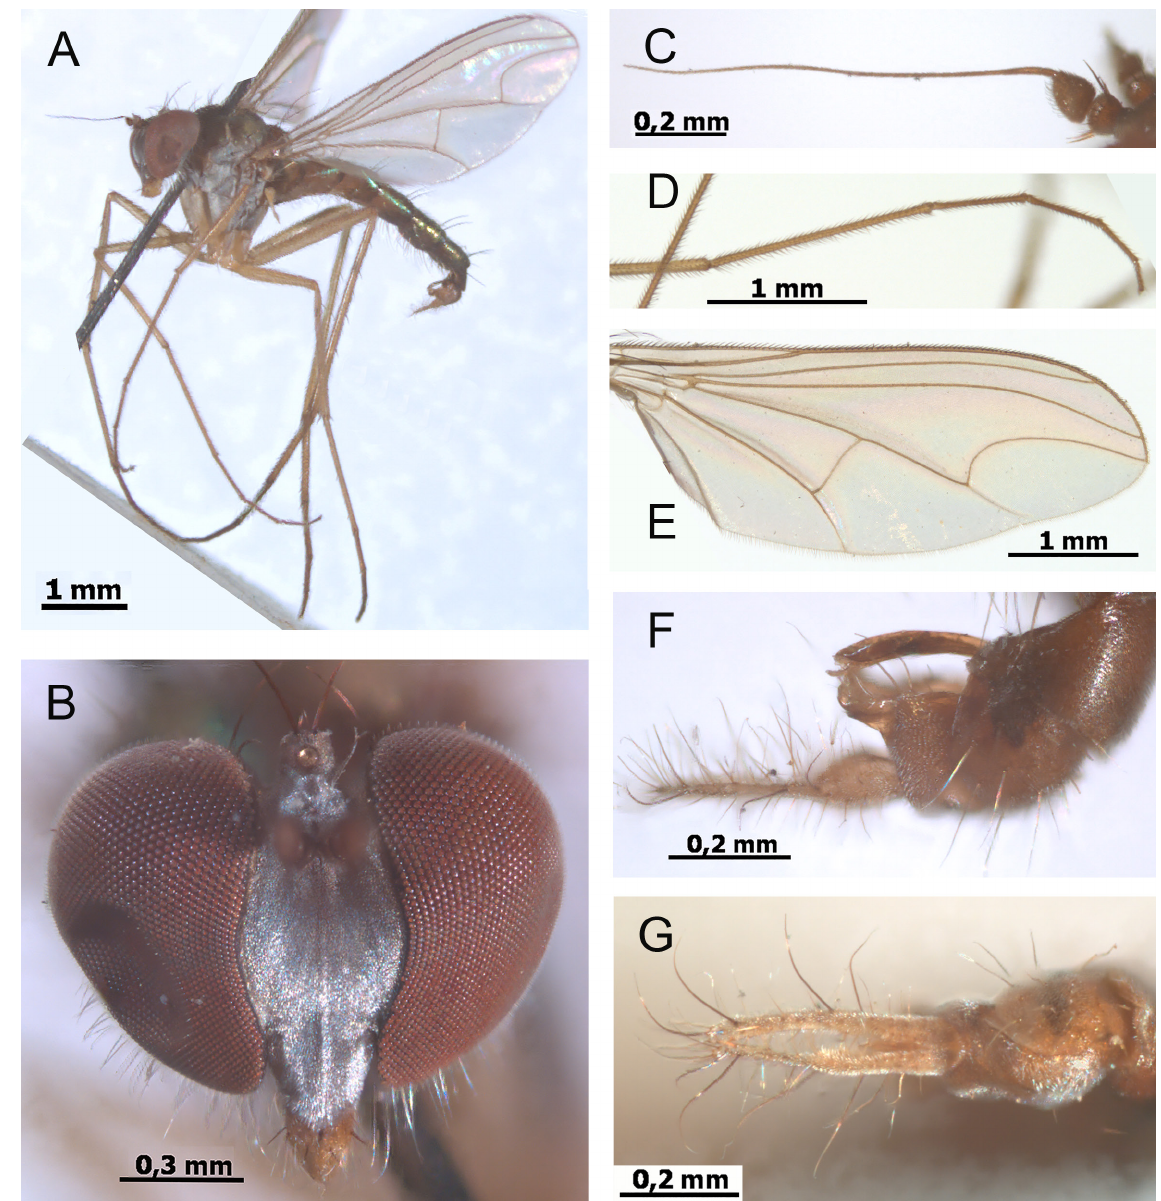
Fig. 3. Amblypsilopus bevisi (Curran, 1927), ♂, Natal, Edendale (NMSA). A . Habitus. B . Head. C . Antenna. D . Fore tarsus. E . Wing. F . Hypopygium, left lateral view, dry. G . Hypopygium, dorsal view,